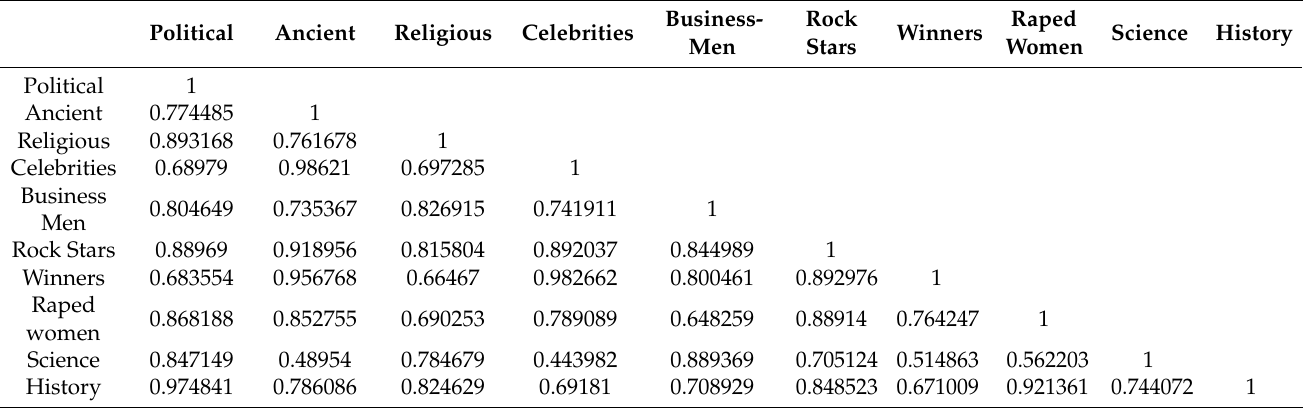
Table 4. The correlation matrix for the different categories regarding the measures of general